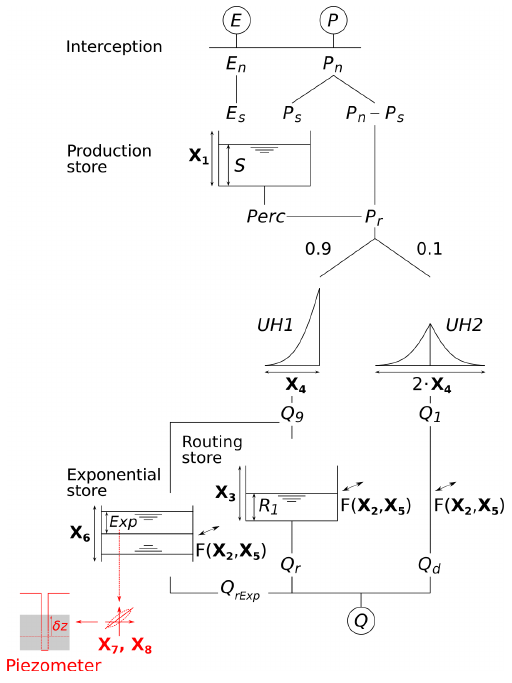
Figure 4. Structure of the original GR6J model – in black – and the built-in piezometry simulation module – in red. See Table C1 in Appendix C for the definitions of the parameters and